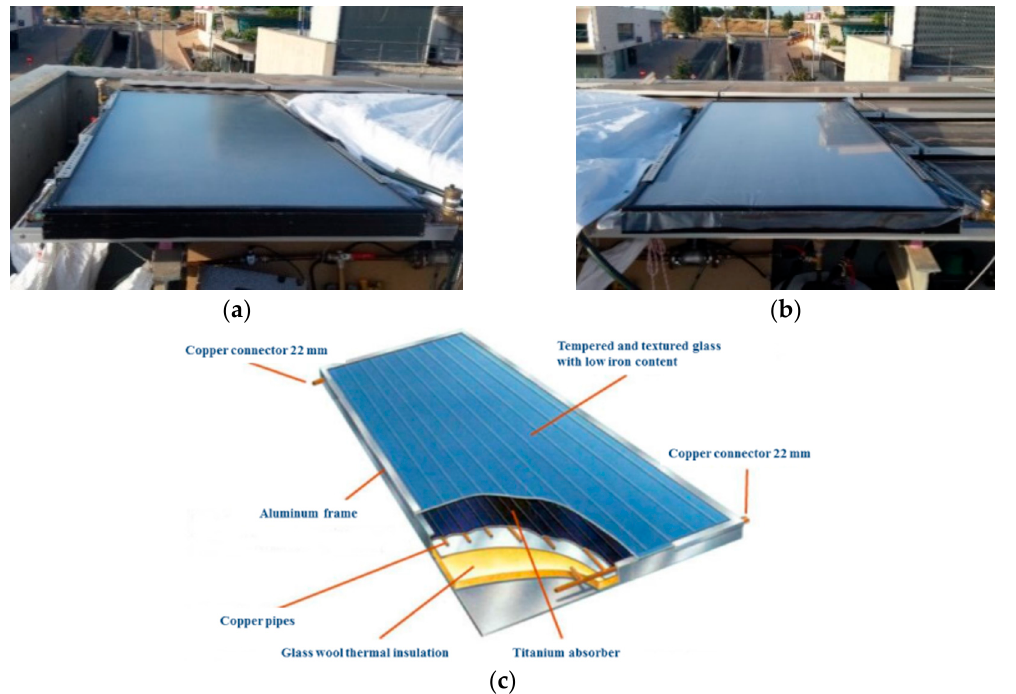
Figure 1. ( a ) Solar collector; ( b ) modified solar collector used as a radiative cooling device; ( c ) structure of the solar collector FUJI-P (adapted from manufacturer’s technical data [40]).